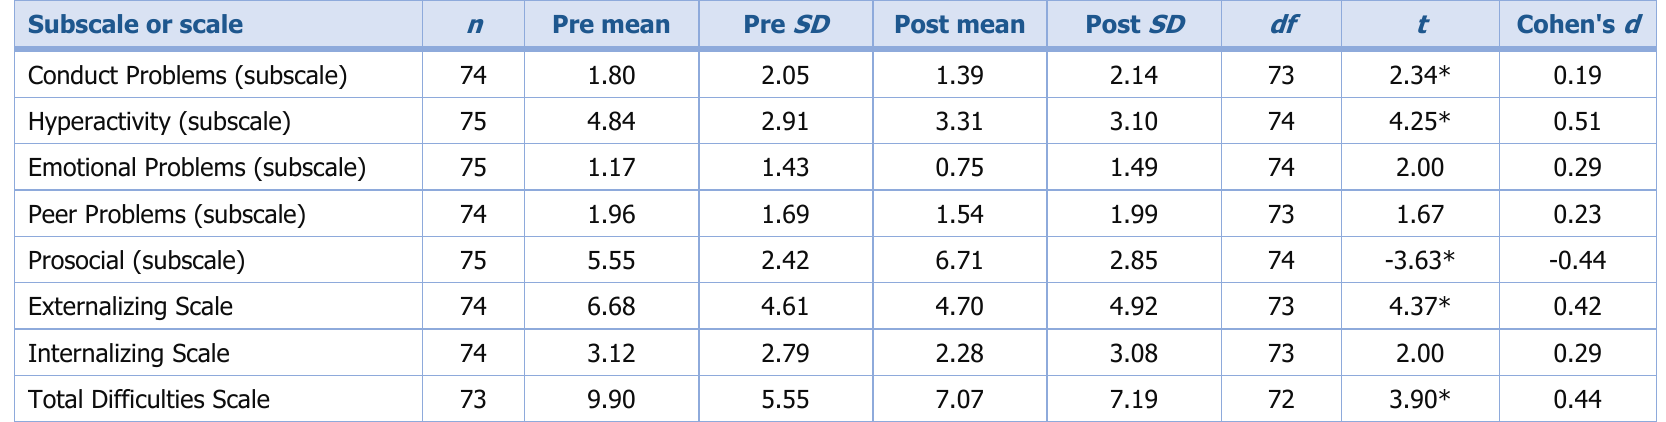
Table 2. Paired Samples t-Test Results for the Strength and Difficulties Questionnaire Scales and Subscales Subscale or